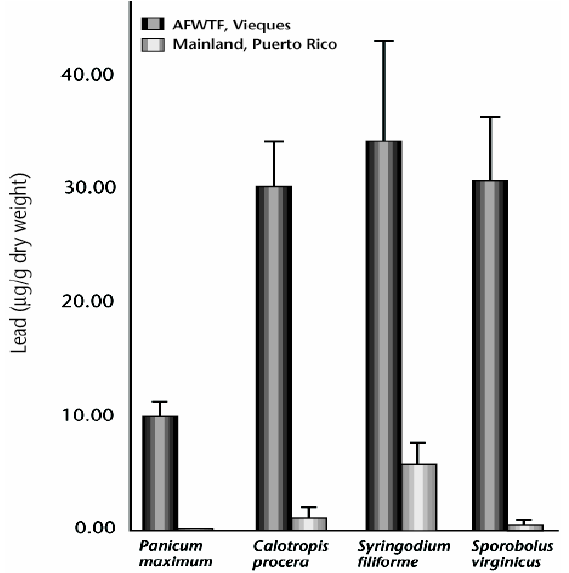
Figure 2: Average content of lead (Pb) in various plant species from the AFWTF (Vieques) and reference location (Mainland, Puerto